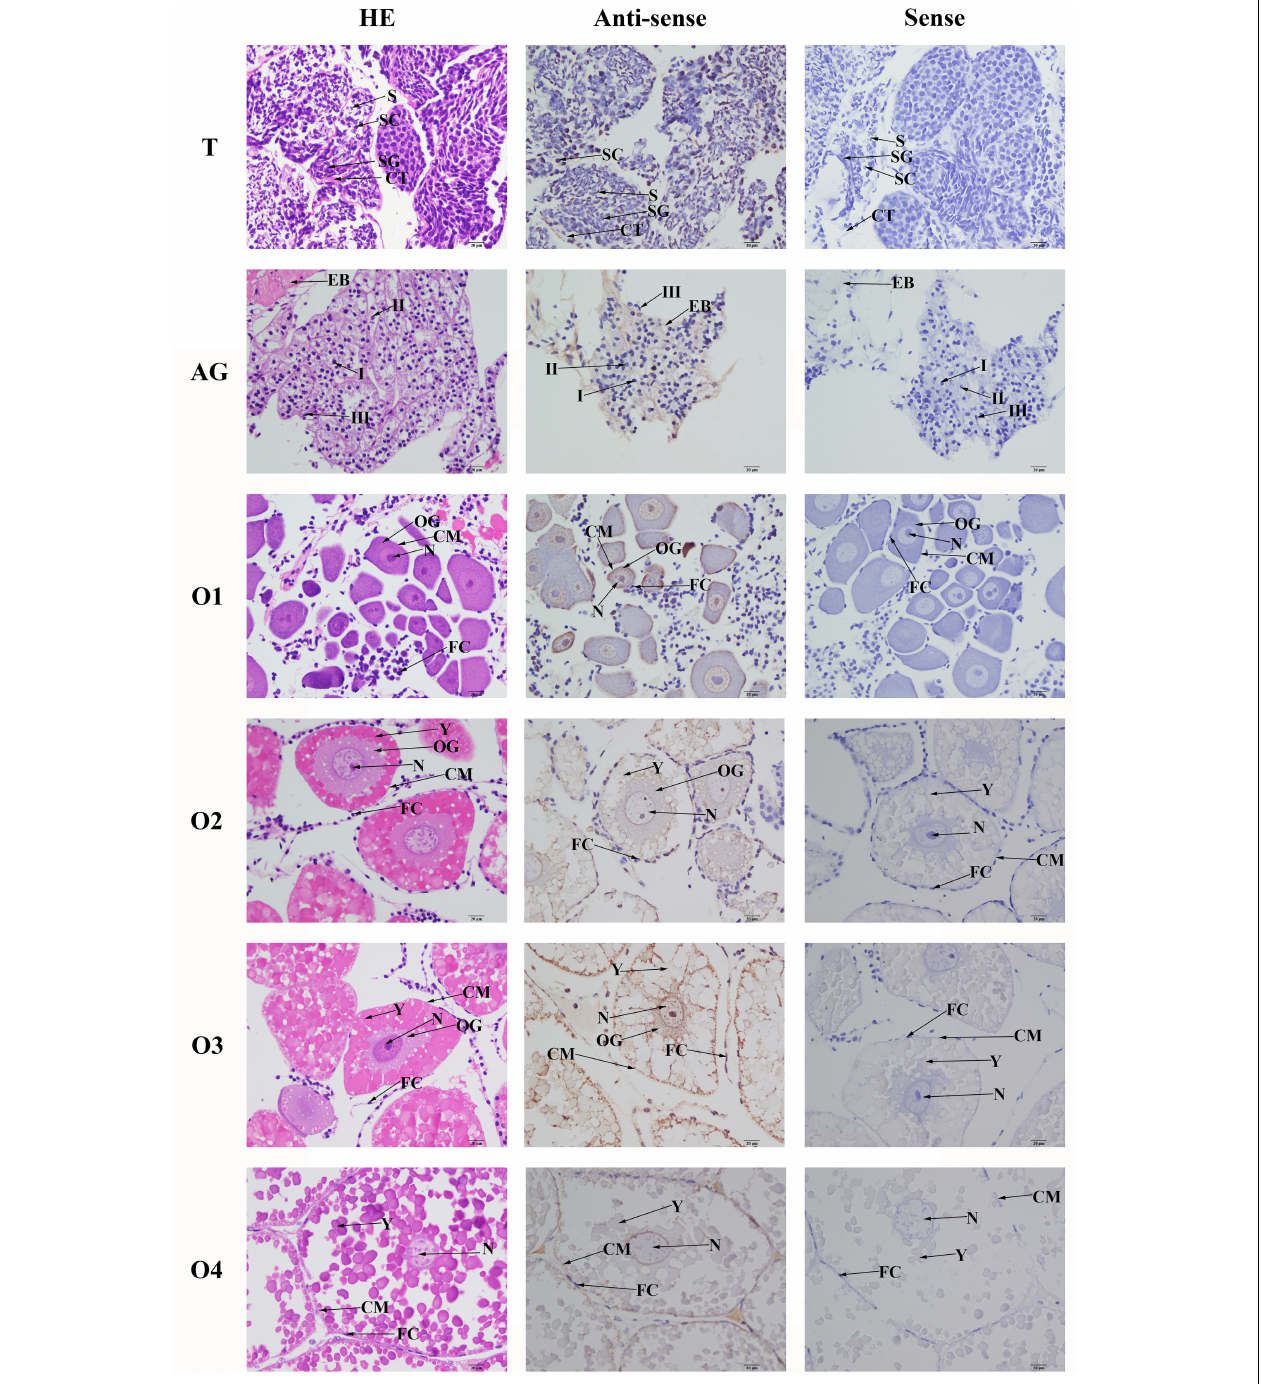
FIGURE 7 | In situ hybridization analysis of Mn-SDHB gene in testis and androgenic gland from reproductive season, and different ovarian reproductive cycle of M . nipponense . ST, seminiferous tubule; SG, Spermatogonia; SC, spermatocyte; S, sperm; CT, collecting tissue; E, wall epithelium; EM, eosinophilic matrix; VD, vas deferens; EB, ejaculatory bulb; OG, oogonium; OC, oocyte; CM, cytoplasmic membrane; N, nucleus; Y, yolk granule; FC, follicle membrane. Scale bars = 20 µ